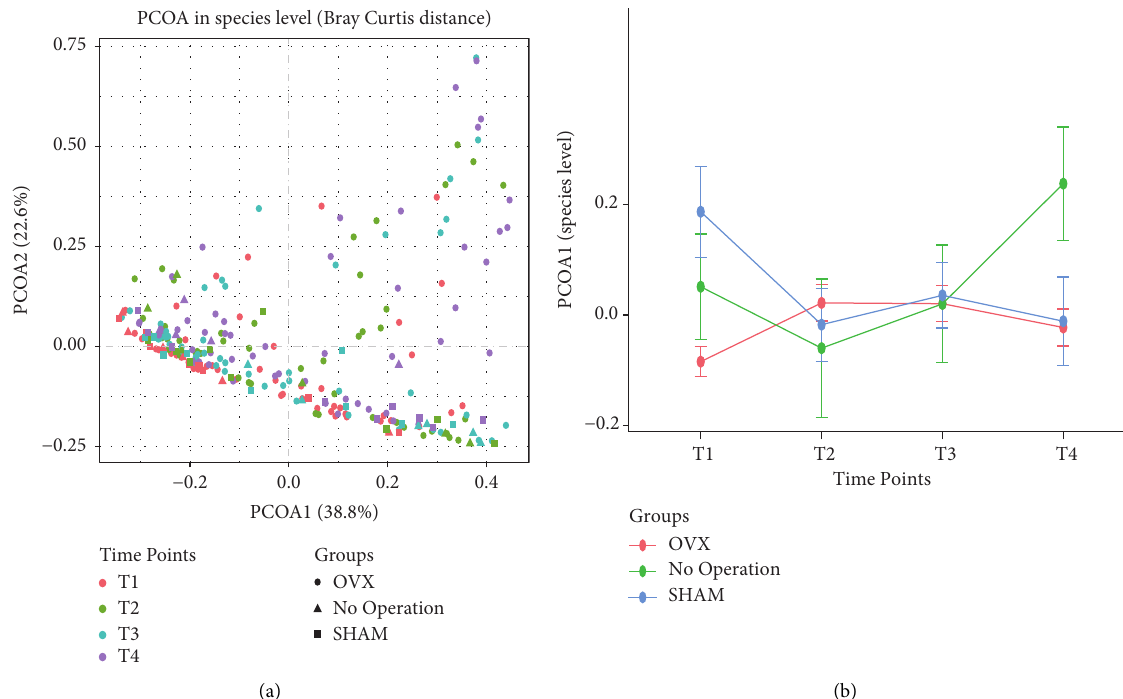
Figure 1: The distribution of the gut microbiota species in the SHAM group is highly consistent with that in the no operation group. The Bray–Curtis distance based on the species relative abundance was calculated. (a) The independent distribution of the gut microbiota species in the OVX, no operation, and SHAM group. The percentages of the first and second principal components are 38.8% and 22.6%, re- spectively. (b) Line plot of the three groups of mice at different time